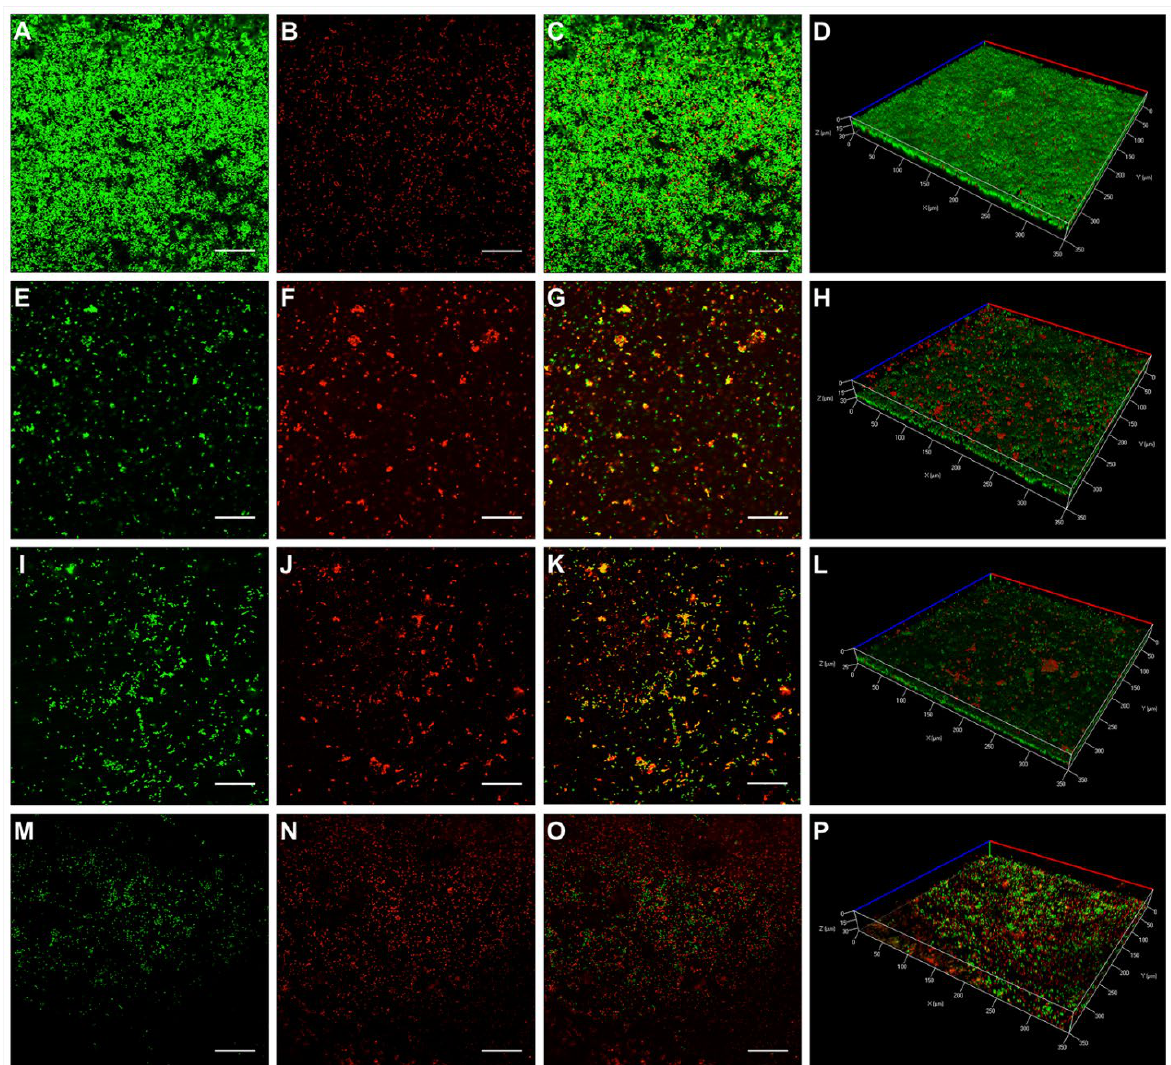
Figure 2. Representative CLSM images of E. faecalis biofilms on HA disks. Images of 48 h-old E. faecalis ATCC 29212 biofilm were acquired by CLSM after exposure to H 2 O (control, A–C ), Ca(OH) 2 -saturated solution ( E–G ), KP (100 µg/mL, I–K ), and L18R (50 µg/mL, M–O ) for 24 h. Shown in each line is the same field (single focal plane). From left to right: SYTO-9 (green, viable cells), propidium iodide (red, dead cells), merged image of viable and dead cells. 3D reconstructions of the selected fields (full thickness, merged images) are shown in panels D (control), H (exposed to Ca(OH) 2 -saturated solution), L (exposed to KP), and P (exposed to L18R). Notably, in the L18R-treated sample, the 3D reconstruction shows a reduced thickness of the biofilm in comparison to the untreated control. Bar = 50 µm.